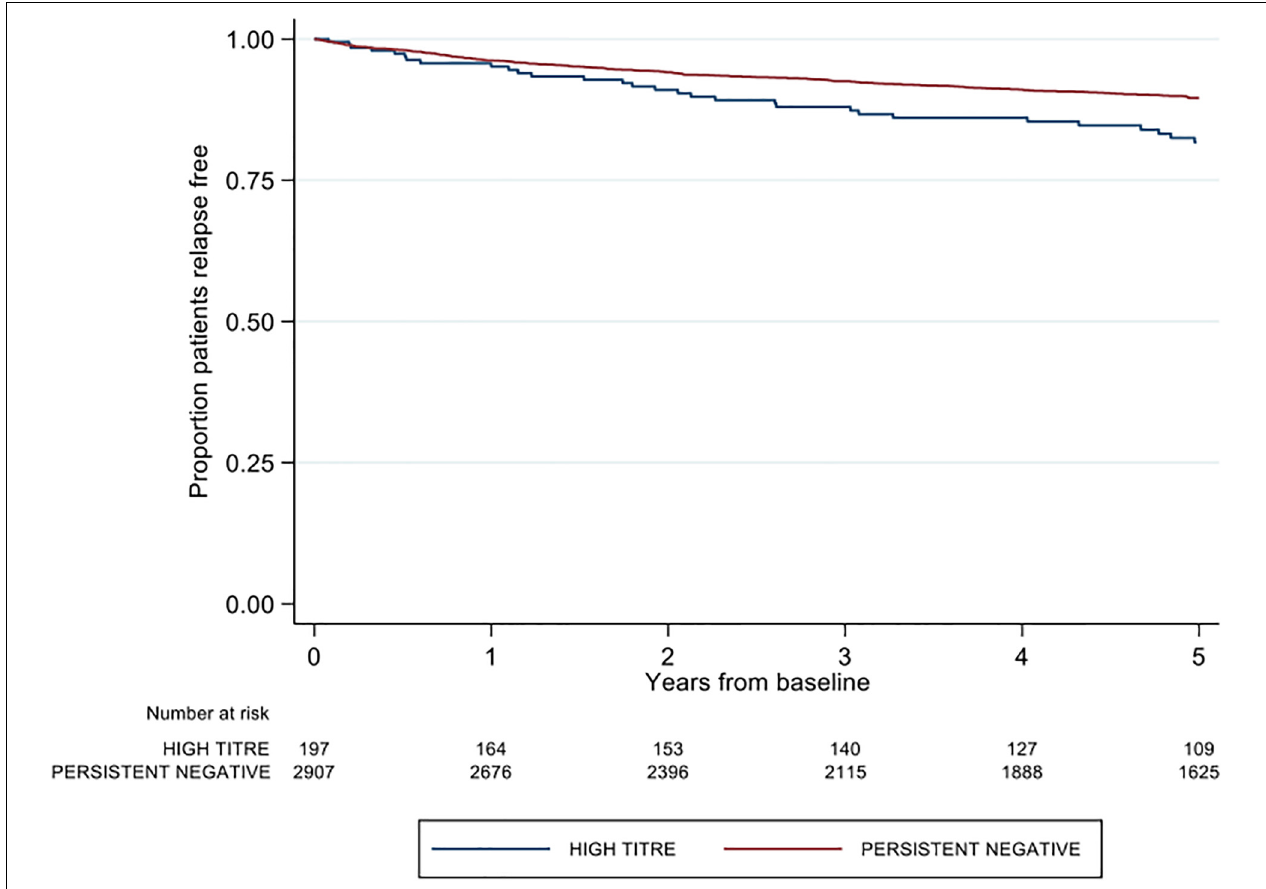
FIGURE 2 | Kaplan-Meier curve demonstrating the rate of first post-baseline relapse by neutralizing antibody titre group over a five-year